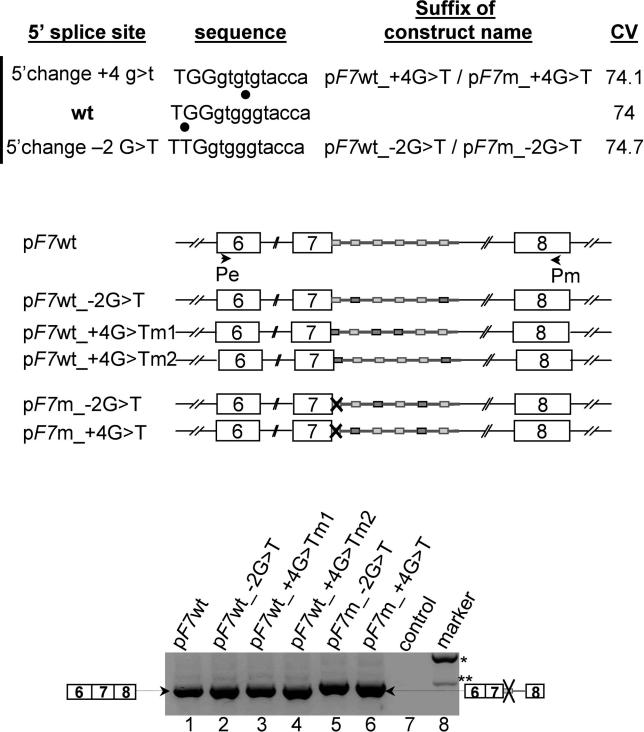
Role of G Triplets in IVS7 Splice Site RecognitionTop: Wild-type (middle line) and mutated (lower and upper lines) 5′ pseudo-sites in the F7 minigene. Dots show the location of the introduced mutations. Suffixes of the constructs' names and the resulting CVs are indicated. Middle: Schematic representation of the constructs transfected in CHO cells. Mutated splice sites are represented by a hatched box (see legend to Figure 2A for the meaning of each symbol). Bottom: RT-PCR amplification of F7 transcripts isolated from CHO cells transfected with the above-mentioned constructs. The products corresponding to the different PCR fragments, as identified by sequencing, are schematically represented on both sides of the figure.